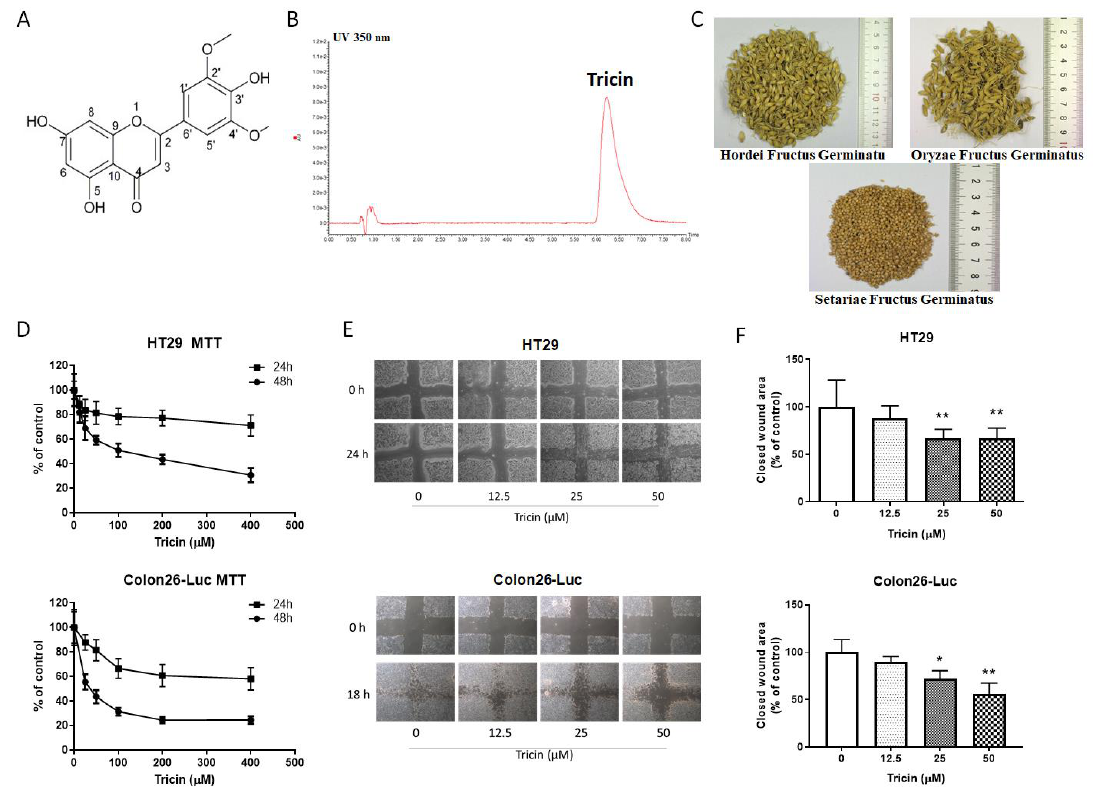
Figure 1. ( A ) Chemical structure of tricin. ( B ) UPLC chromatogram showing the peak of tricin detected at UV350 nm. ( C ) Photos of Hordei Fructus Germinatu, Oryzae Fructus Germinatus and Setariae Fructus Germinatus. ( D ) Effects of tricin on viability of HT29 and Colon26-Luc cells by MTT assay. Data were expressed as the mean percentage of the control (4 independent experiments with 4 replicates each, mean ± S.D.). ( E – F ) Effects of tricin on motility of ( E ) HT29 cells and ( F ) Colon26-Luc cells by scratch wound assay. Data were expressed as the mean percentage of untreated control (4 independent experiments with duplicate each, mean + S.D.). Statistical differences were determined by one-way ANOVA, followed by Tukey multiple comparisons test, with * p < 0.05, ** p < 0.01 against untreated control.